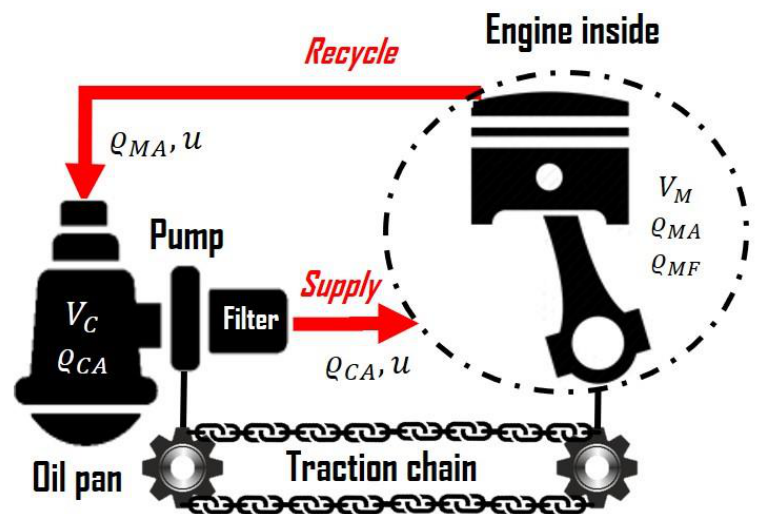
Figure 1. Functional diagram of the lubrication system.